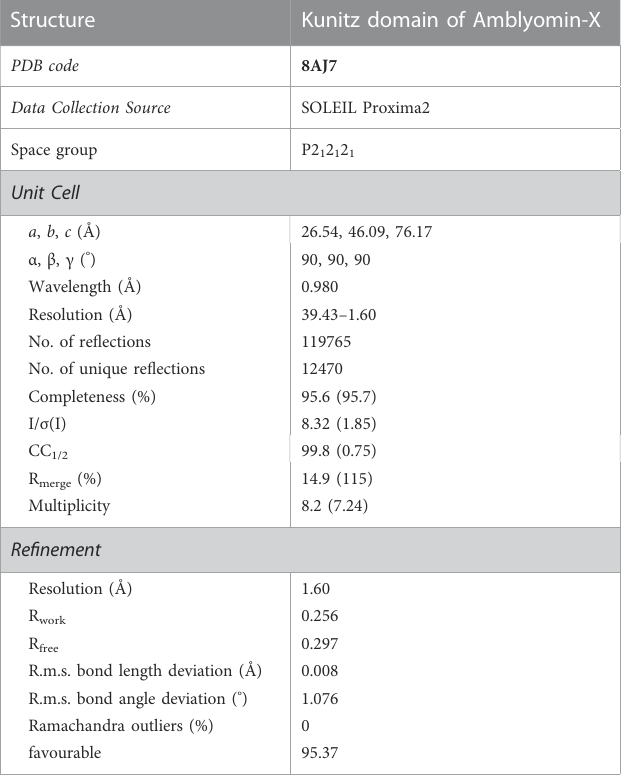
TABLE 2 Crystallography of Kunitz domain of Amblyomin-X. Crystallographic data and re fi nement statistics. Structure